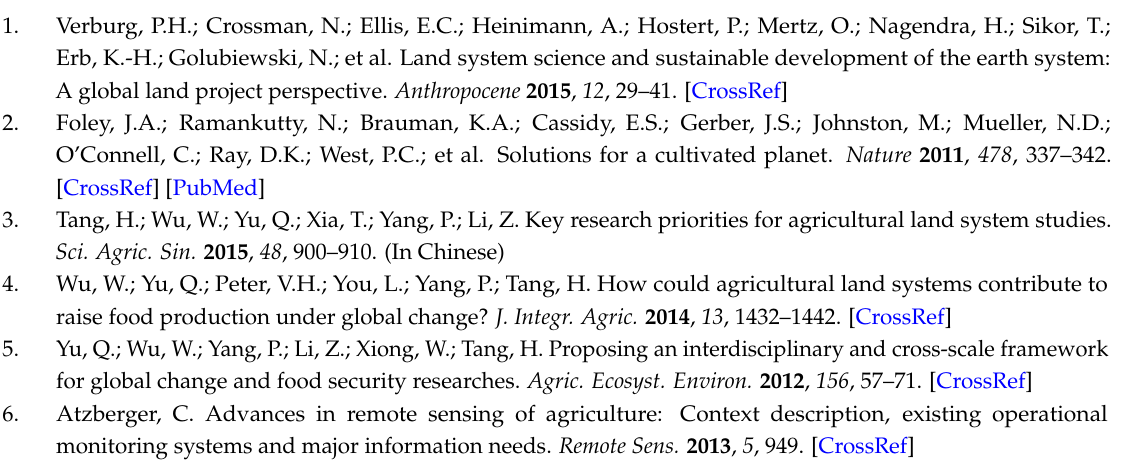
Figure S1: Estimated workload for a county level database, Figure S2: A color-blinded figure describing the overview of the eFarm system, Table S1: Estimated coverage of cropland area, number of land parcels, and number of farmer household at an average level for each county, Table S2: Estimated data volume of basemaps (unit: byte), Table S3: Estimated data volume of created household and land parcel (unit: byte), Table S4: Estimated data volume of sensed land use information (unit: